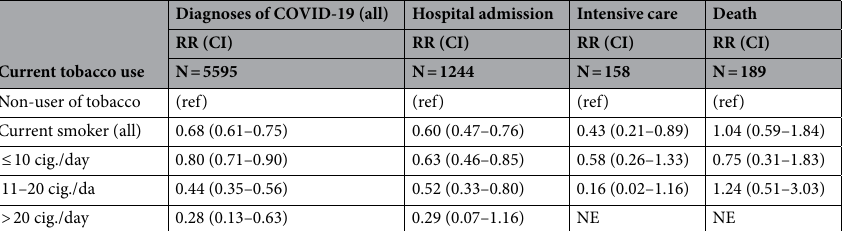
Diagnoses of COVID-19 (all) Hospital admission Intensive care Current tobacco use